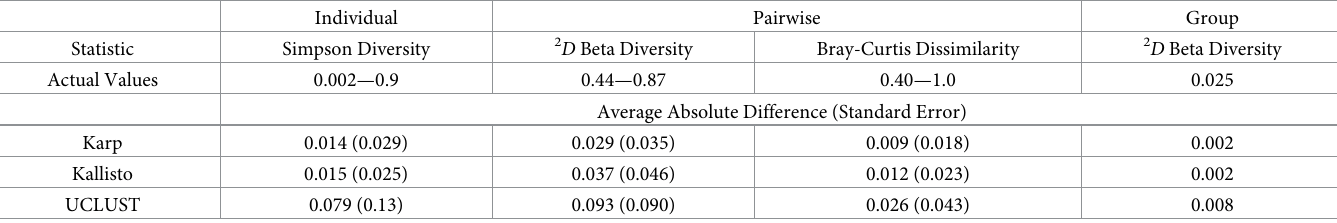
Table 2. Summaries of microbiome data were calculated from 100 simulated samples containing different mixtures of 1,000 references. Only reference sequences with frequencies > 0.1% were used to calculate the statistics. In each sample the absolute value of the difference between the actual statistic and that estimated by Karp, Kal- listo, and UCLUST was calculated. The group-wise Beta Diversity value was a single estimate from all 100 samples; it is not an average and therefore there is no standard